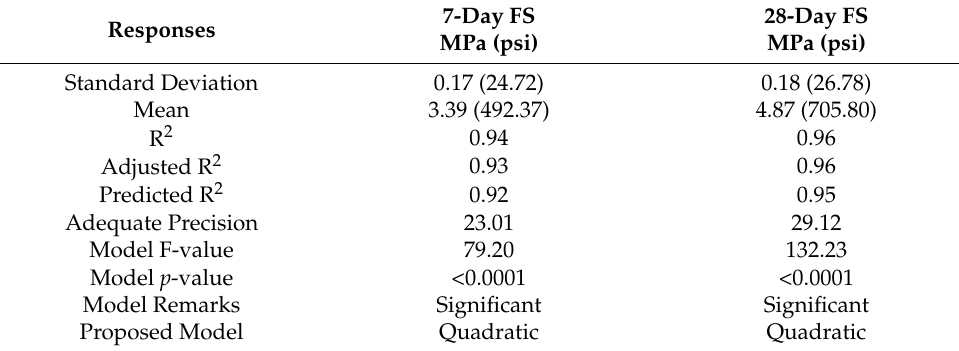
Table 7. ANOVA and fit statistics of flexural strength.